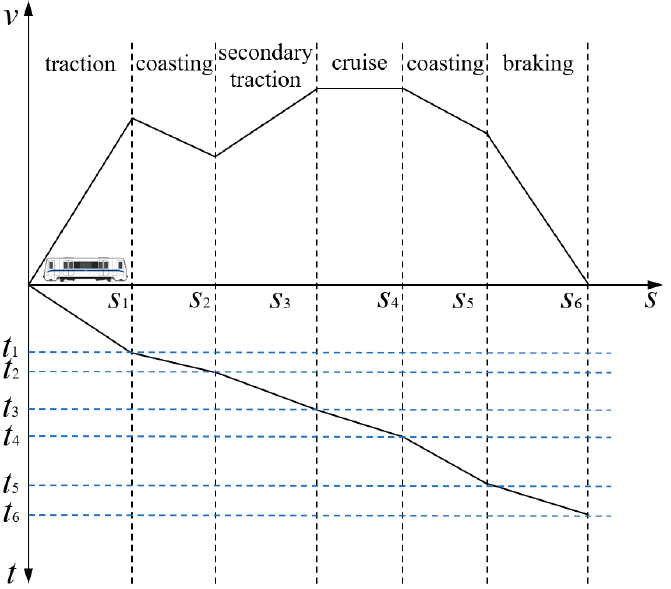
Figure 1. Schematic diagram of train operating conditions.